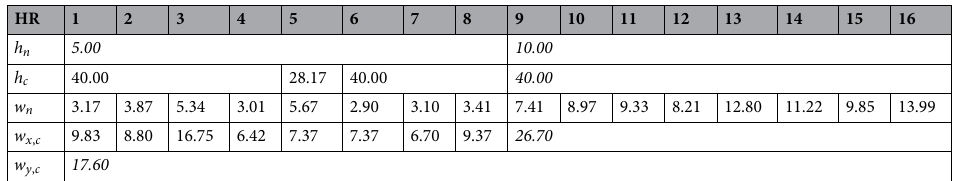
Table 2. Geometrical parameters of the HRs composing the optimized FMAA. All dimensions are in mm. The values in italic correspond to the parameters values that are fixed before the optimization.